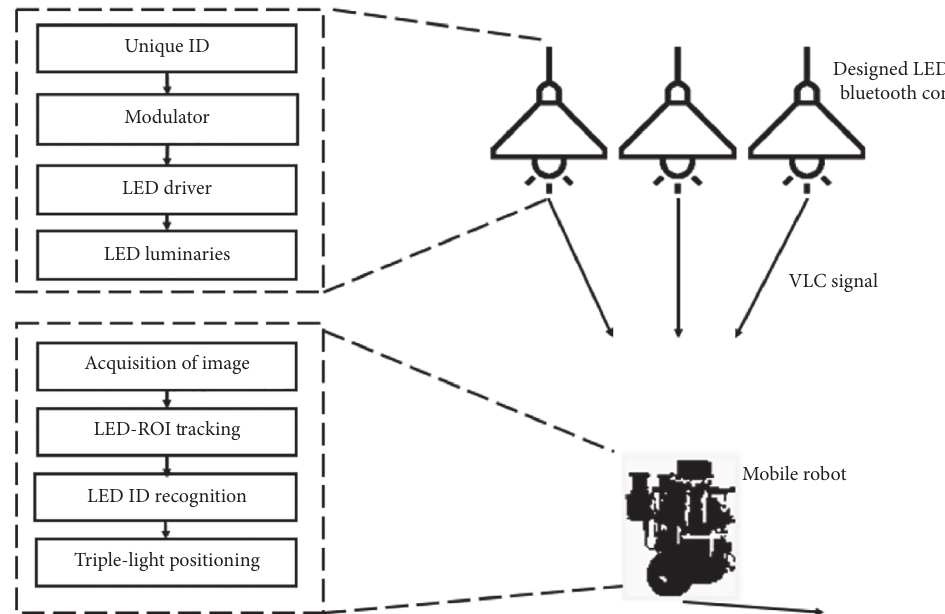
Figure 1: The architecture of the VLP-based robot system.